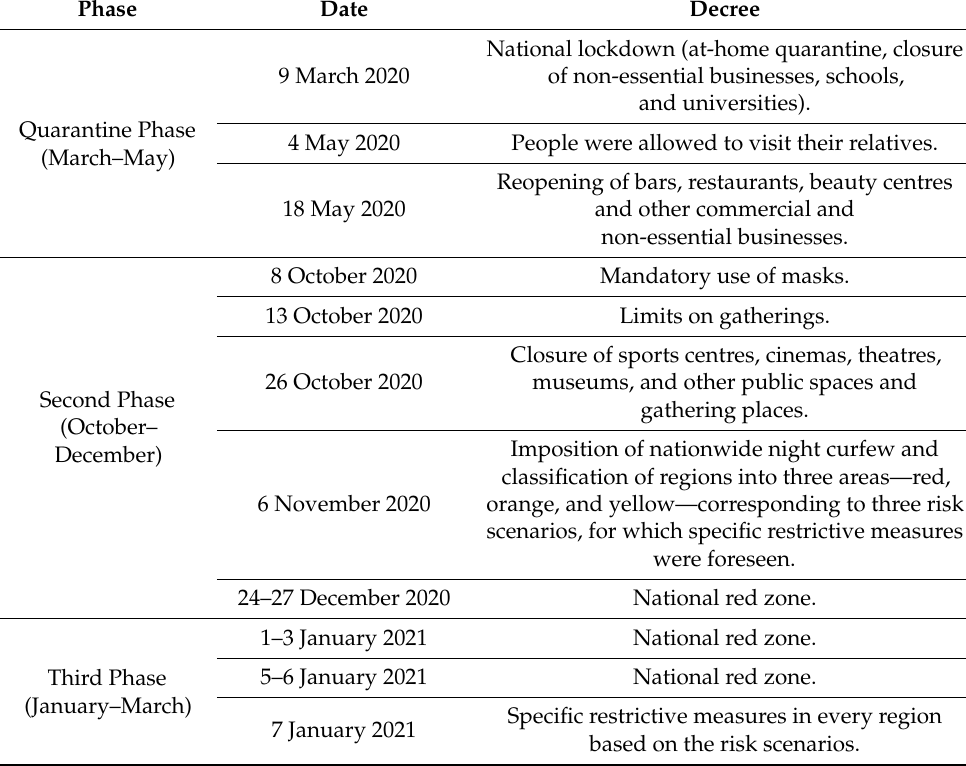
Table 1. Containment measures in